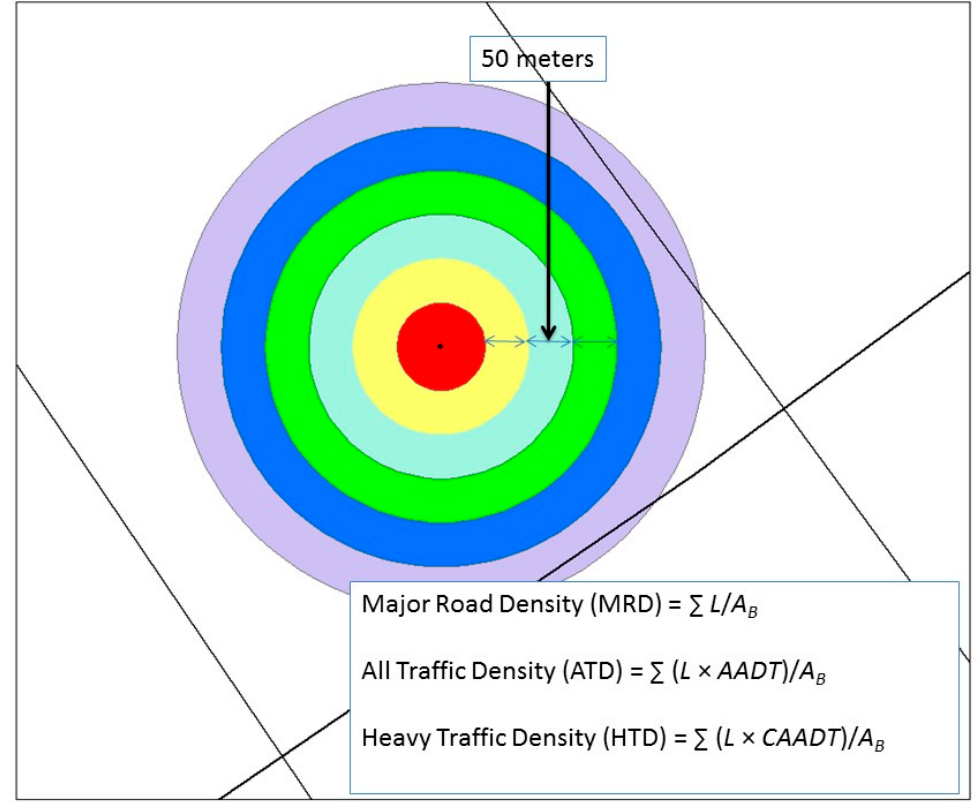
Figure 1. Concentric areas surrounding a participant’s home for calculating different traffic-related metrics. L and A B represent length of major road and buffered area around the selected site, respectively. AADT and CAADT represent annual average daily traffic and commercial annual average daily traffic, respectively.